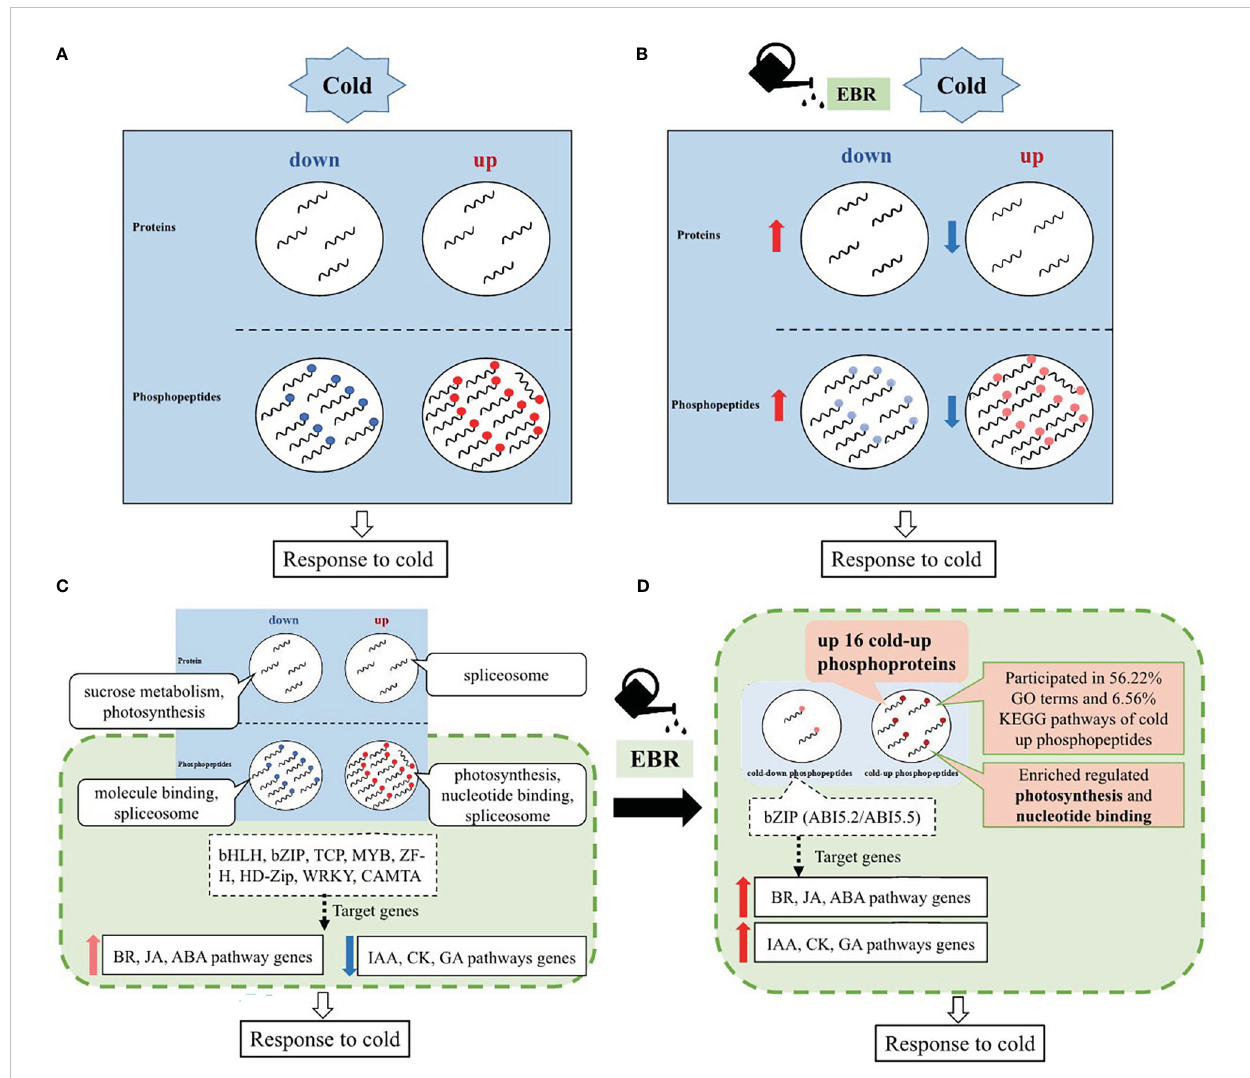
FIGURE 8 Schematic representation of a possible EBR-regulated comprehensive cold response model in cucumber. (A) The effects of cold stress on proteins and phosphopeptides of cucumber; (B) the effects of EBR on cold-responsive proteins and phosphopeptides of cucumber; (C) a schematic representation of a comprehensive cold response model of cucumber; and (D) a schematic representation of EBR-regulated comprehensive cold response model of